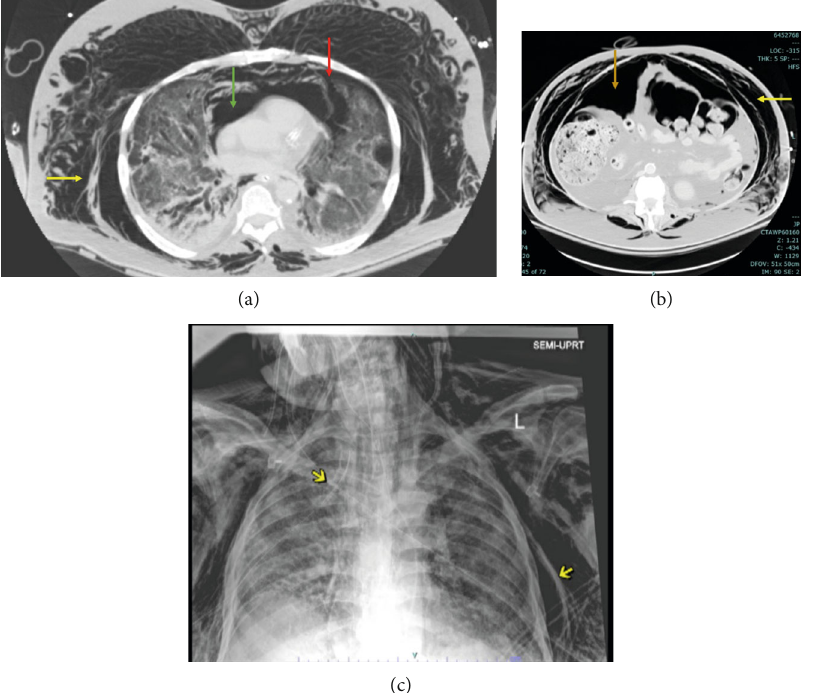
Figure 1: (a) CT of the chest showing moderate-sized left pneumothorax (red arrow), pneumomediastinum (green arrow), and extensive subcutaneous emphysema of the chest wall (yellow arrow). (b) Abdominal CT with large pneumoperitoneum (brown arrow) and subcutaneous emphysema of the abdominal wall (yellow arrow). (c) CXR demonstrating right-sided chest tube and subcutaneous emphysema of chest